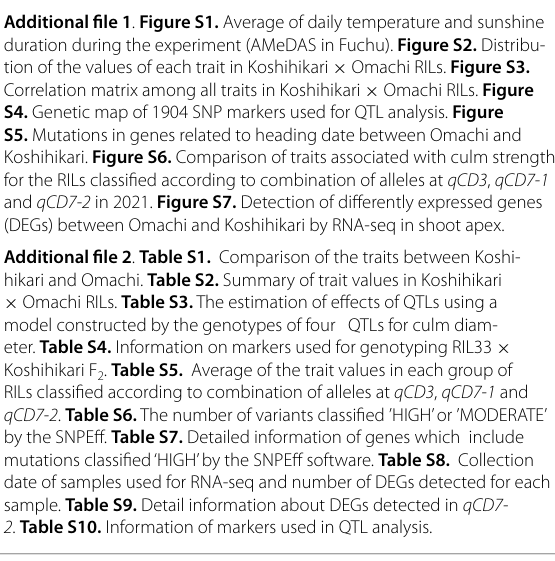
Omachi RILs. Figure × S4. Genetic map of 1904 SNP markers used for QTL analysis. Figure S5. Mutations in genes related to heading date between Omachi and Koshihikari. Figure S6. Comparison of traits associated with culm strength for the RILs classified according to combination of alleles at qCD3 , qCD7-1 and qCD7-2 in 2021. Figure S7. Detection of differently expressed genes (DEGs) between Omachi and Koshihikari by RNA-seq in shoot apex. Additional file 2 . Table S1. Comparison of the traits between Koshi- hikari and Omachi. Table S2. Summary of trait values in Koshihikari Omachi RILs. Table S3. The estimation of effects of QTLs using a × model constructed by the genotypes of four QTLs for culm diam- eter. Table S4. Information on markers used for genotyping RIL33 × Koshihikari F 2 . Table S5. Average of the trait values in each group of RILs classified according to combination of alleles at qCD3 , qCD7-1 and qCD7-2 . Table S6. The number of variants classified ’HIGH’ or ’MODERATE’